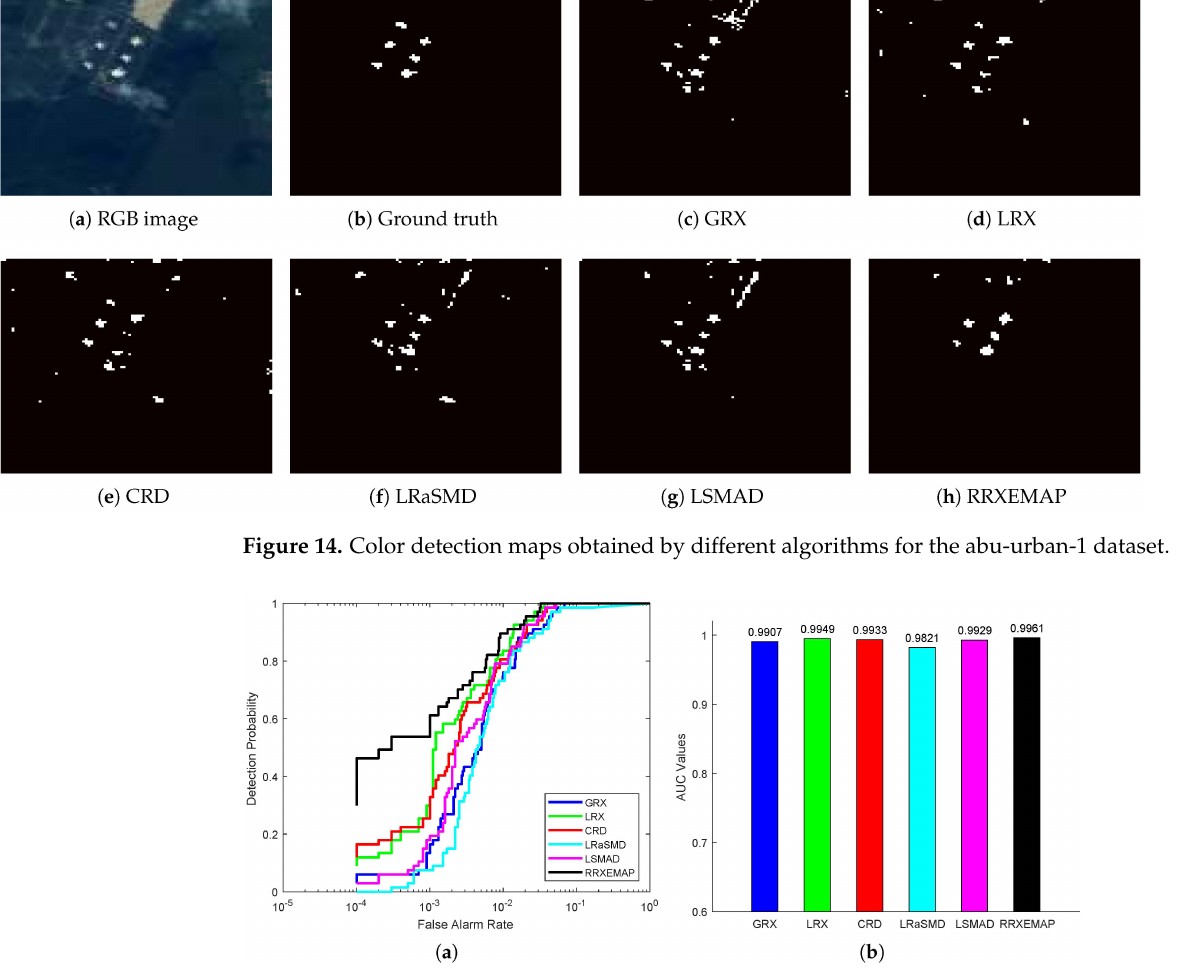
Figure 15. Detection accuracy evaluation for the abu-urban-1 dataset. ( a ) ROC curves. ( b ) AUC values.